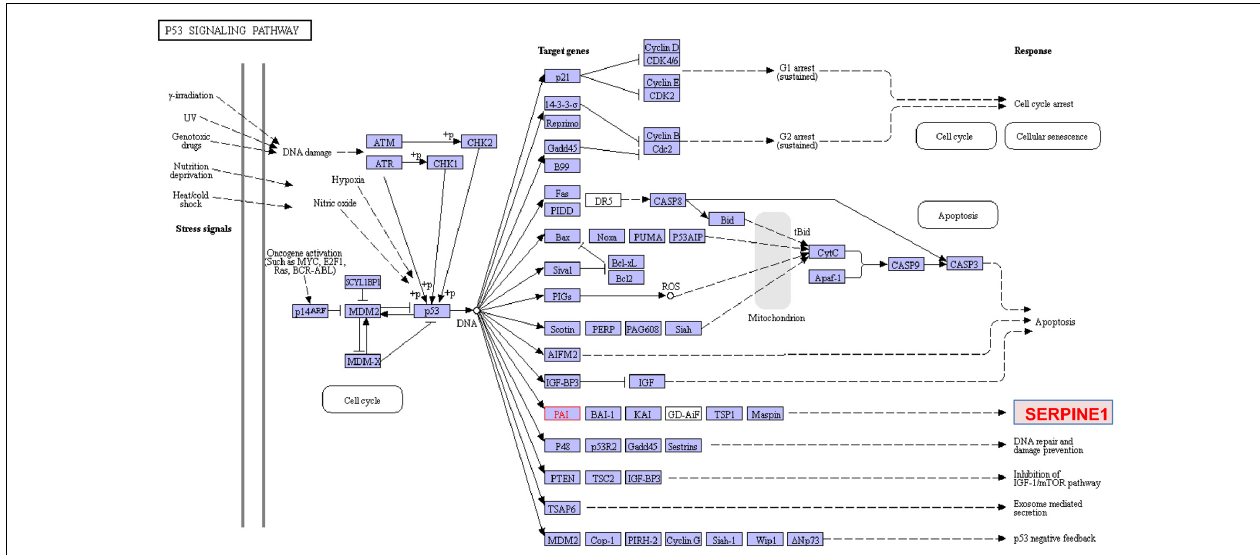
FIGURE 10 | KEGG p53 signaling. p53 is mobilized in response to various signals including DNA damage, oxidative stress and oncogene activation usually by phosphorylation by elements of the ATM/ATR pathway. p-p53 initiates transcription of target genes that result in cell cycle arrest (at both G 1 and G 2 /M), acquisition of a senescent phenotype or apoptosis. SERPINE1 (PAI-1) and p21 are prominent members of both the cellular senescence ( Figure 6 ) and p53 signaling pathways. TGF- β 1 also activates p53 stimulating p53 Ser9 , 15 phosphorylation and acetylation, promoting interactions with activated SMADs and subsequent binding of p53/SMAD3 complexes to the PAI-1 promoter in human renal tubular epithelial cells (Overstreet et al., 2014). Consistent with a potential in vivo role for p53 and SMADs in TGF- β 1-driven renal fibrosis, co-induction of pSMAD2/3, p53, p53 Ser15 and the target growth arrest/senescence genes SERPINE1 and p21 are evident in the tubular epithelium of the obstructed kidney (e.g., Overstreet et al., 2014; Patel et al., 2019).